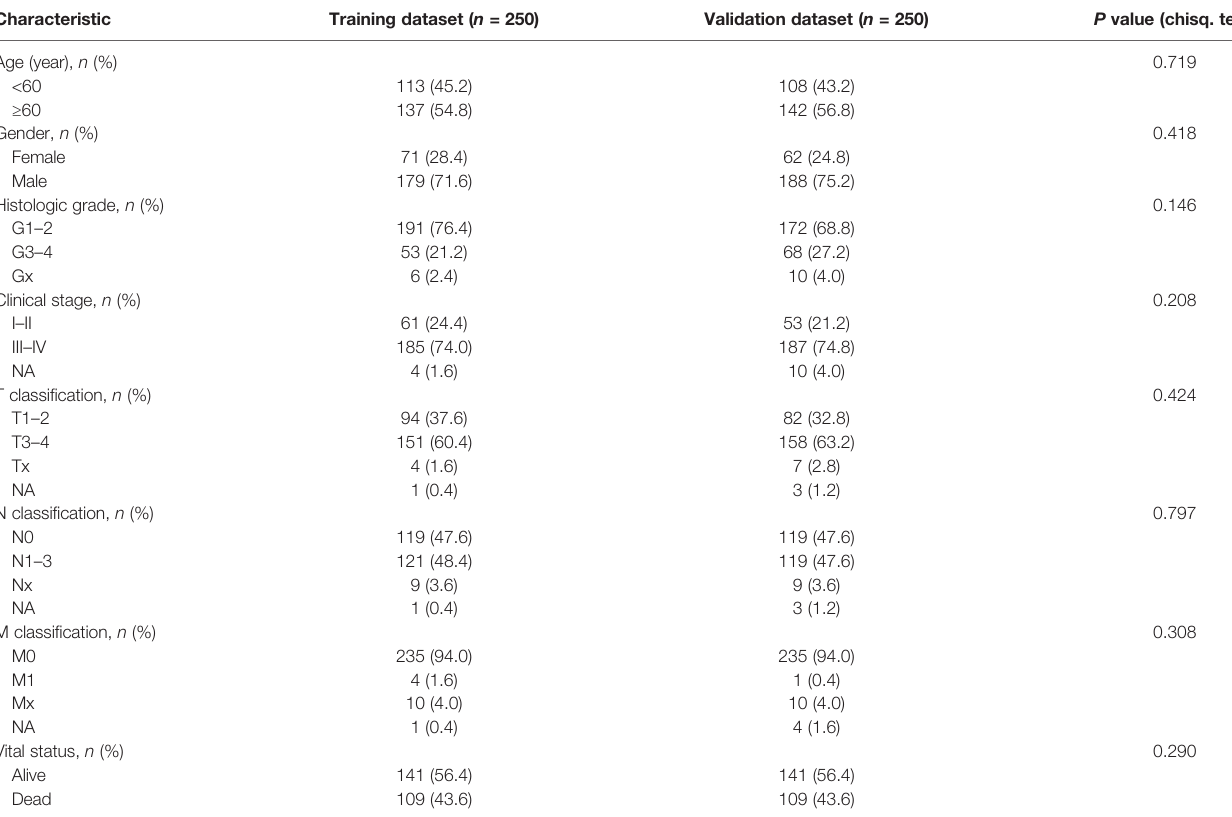
TABLE 1 | HNSCC patients ’ clinical characteristics of training dataset and validation dataset in TCGA ( n = 500).